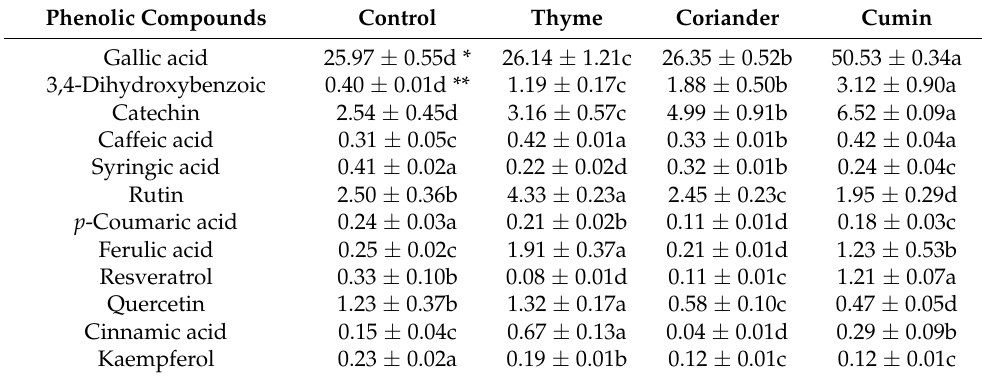
Table 2. Phenolic compounds of “Ke¸skek” samples (mg/100 g).